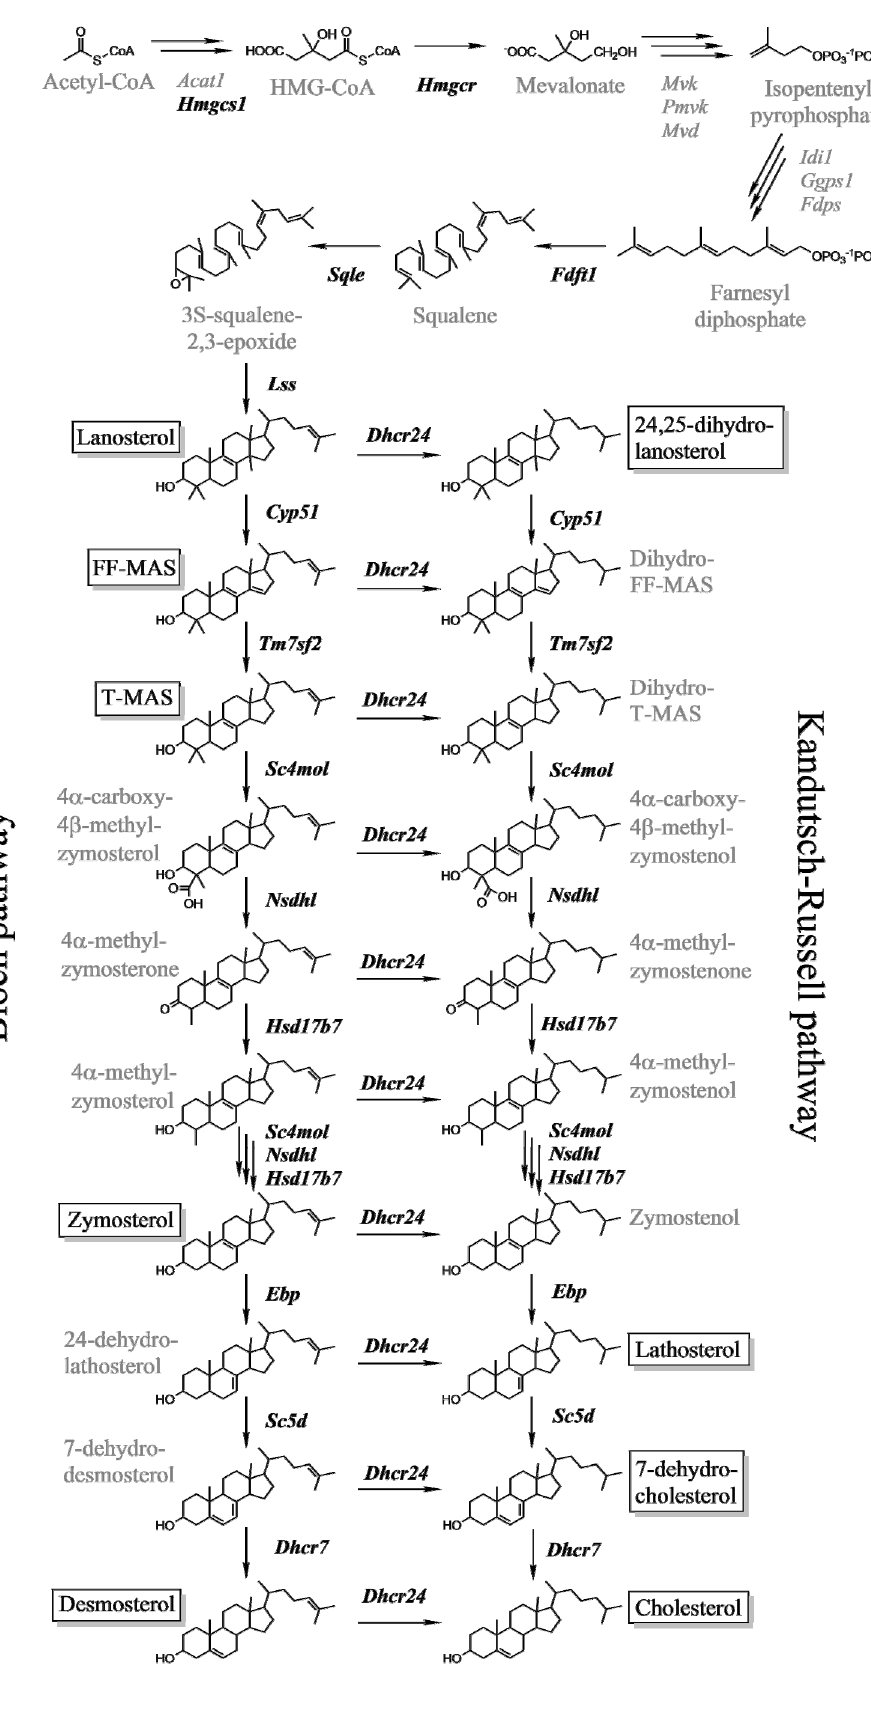
Figure 1. Cholesterol synthesis scheme. The investigated genes are in black bold text and the measured intermediates are in framed black text. Adapted after